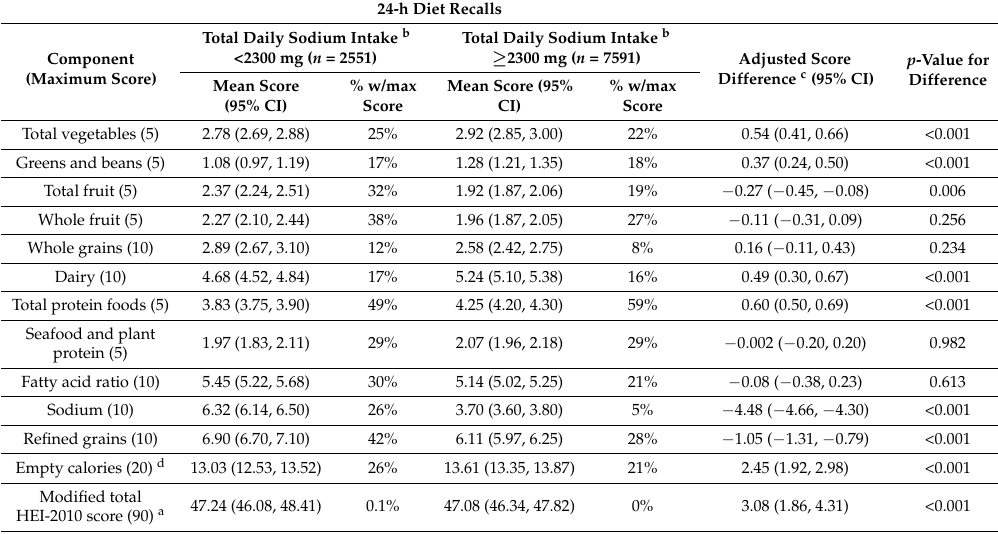
Table 5. Mean Healthy Eating Index-2010 component and modified total scores a and percent with maximum scores by total daily sodium intake b ≤ 2300 mg and >2300 mg for all 24-h diet recalls—National Health and Nutrition Examination Survey, 2011–2014 ( n =